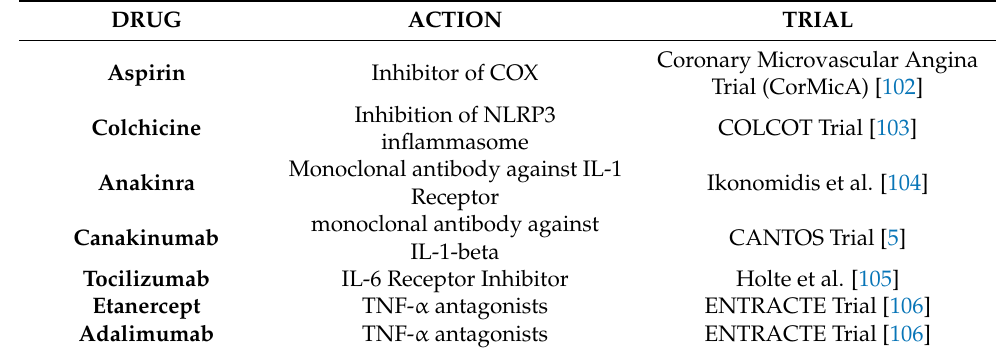
Table 2. Therapeutic anti-Inflammatory agents.